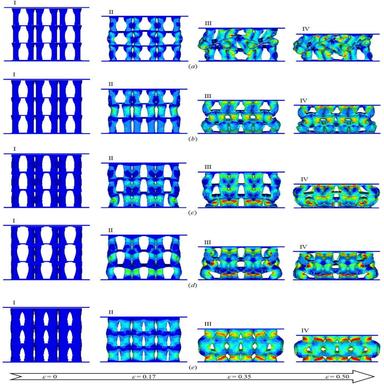
Deformation process of various CLL materials: (a) ¯ 0.160 = ; (b) ¯ 0.213 = ; (c) ¯ 0.261 = ; (d) ¯ 0.303 = ; (e) ¯ 0.343 = . (ε is nominal strain).